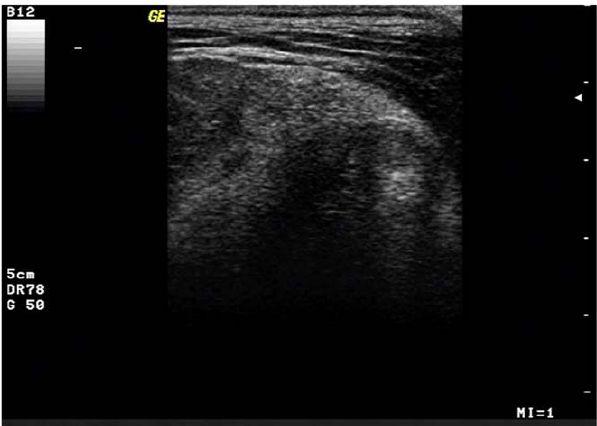
Figure 2. Ultrasound image of an intermuscolar lipoma. An intermuscular lipoma of the caudal region, ultrasonographically appearing hyperechoic and heterogeneous; the capsule is clearly